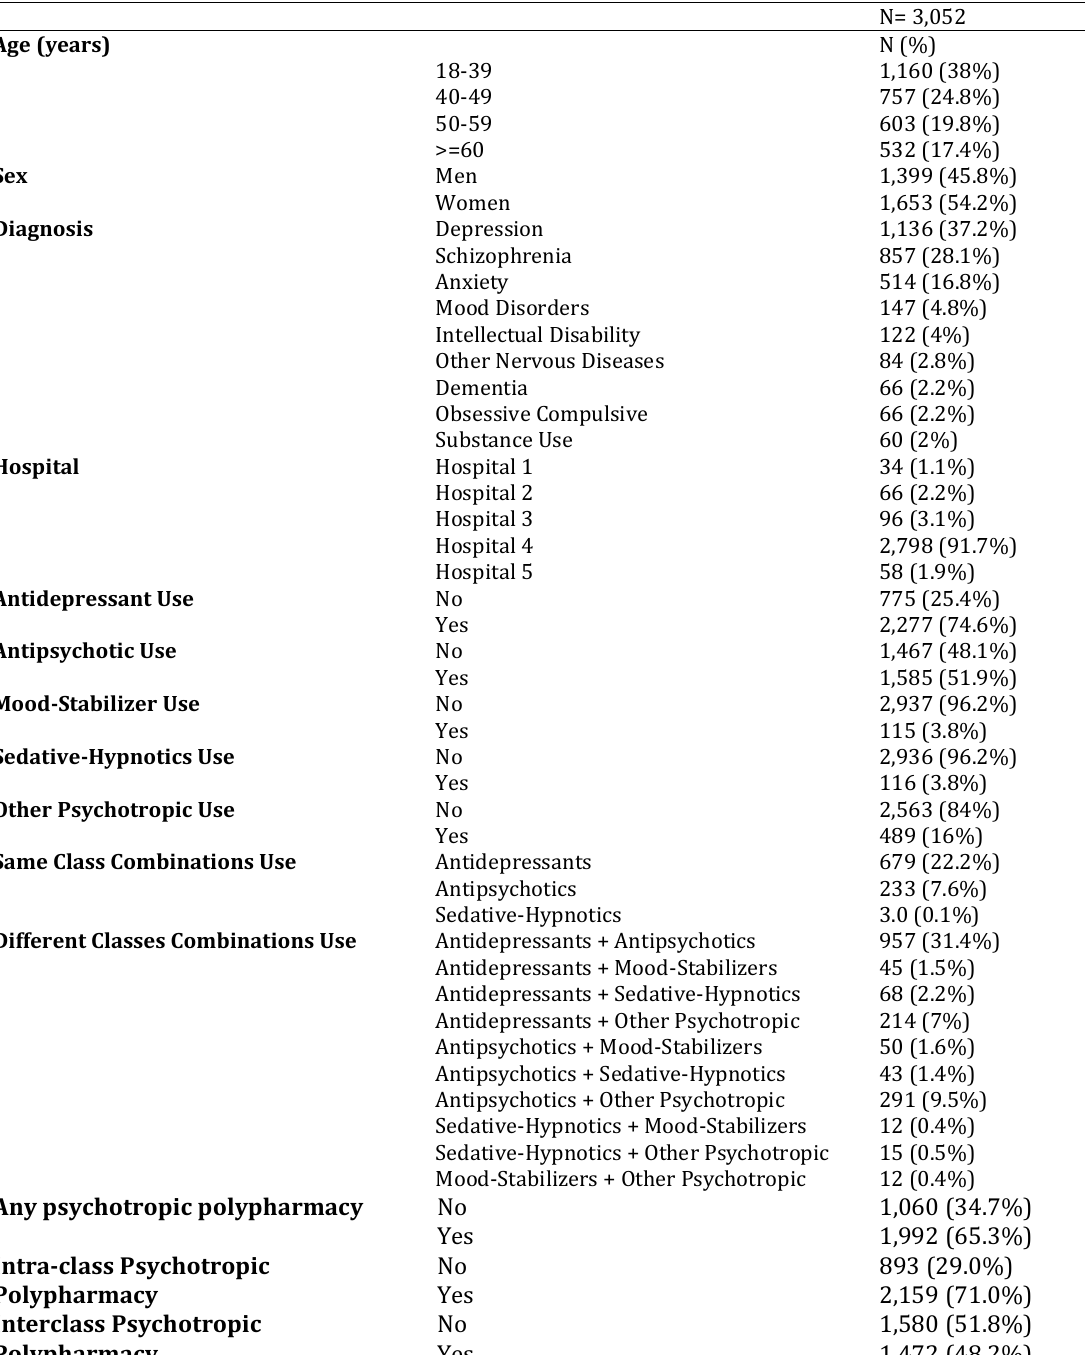
Table I Descriptive Statistics of adults (  18 Years) with behavioral/mental illnesses